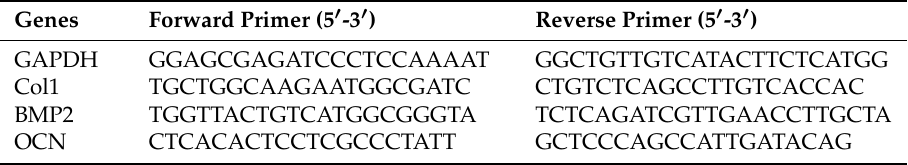
Table 1. Oligonucleotide sequences of primers utilized for real-time qRT-PCR. Genes